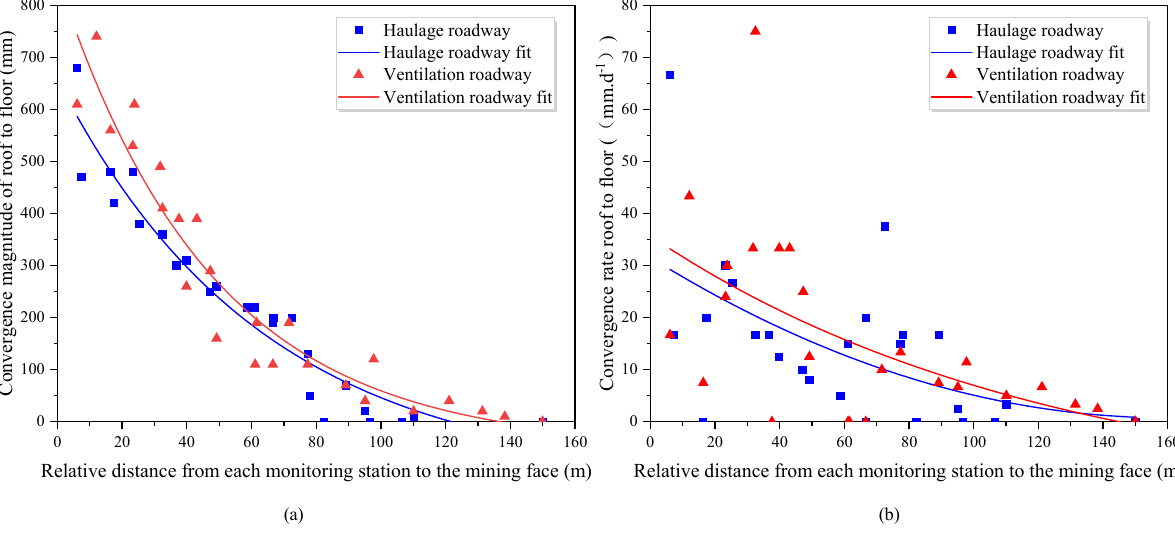
Figure 10. Deformation of the rocks surrounding the roadway rock: ( a ) convergence magnitude; ( b ) convergence rate.